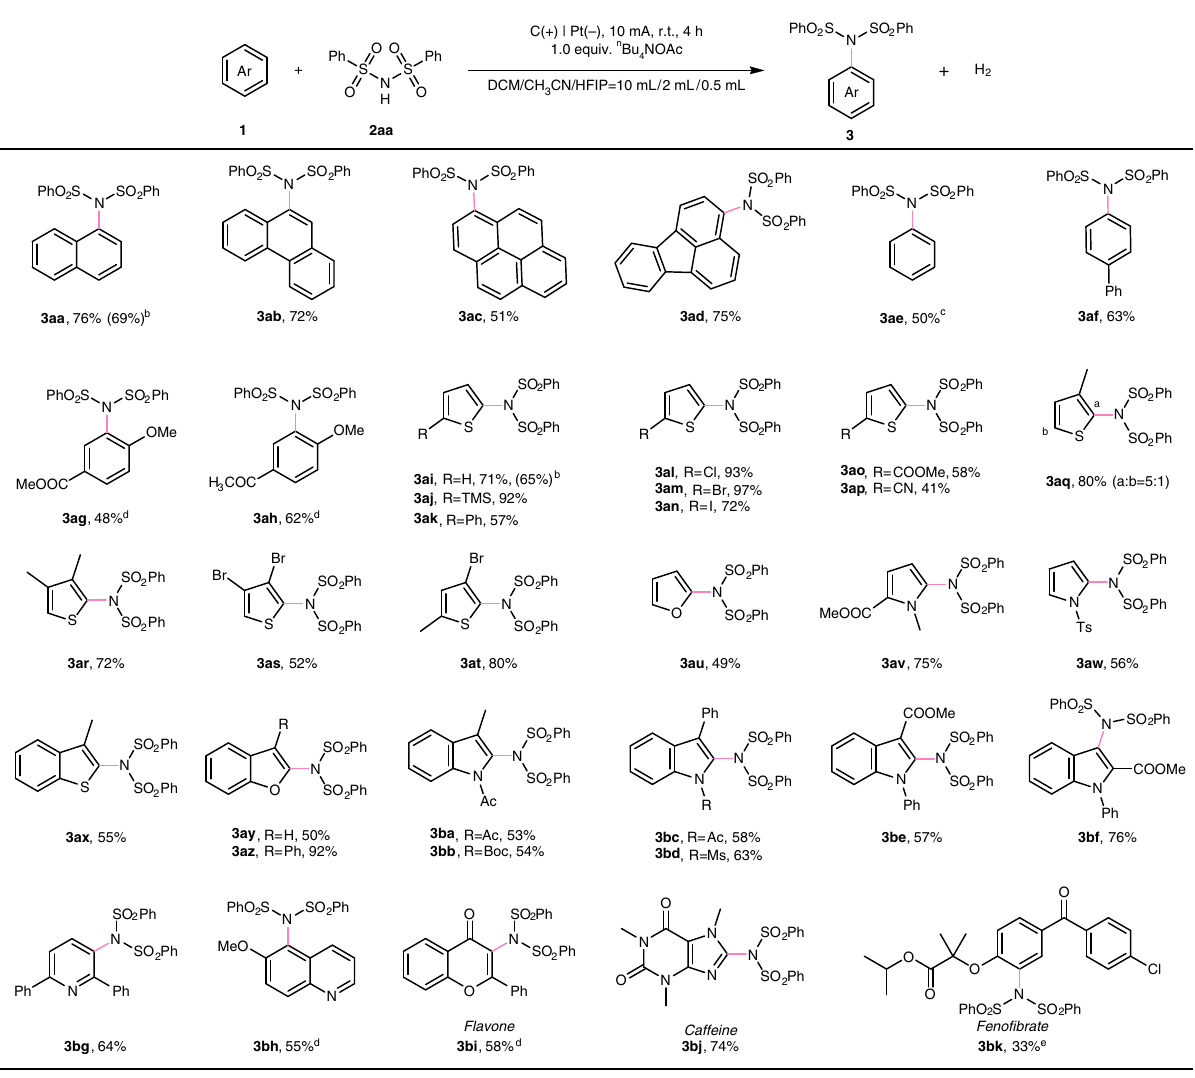
Fig. 2 Substrate scope of aromatic compounds. Reaction conditions: carbon rod anode, platinum plate cathode, constant current = 10 mA, 1 (0.40 mmol), 2aa (0.60 mmol), n Bu 4 NOAc (0.40 mmol), solvent (DCM/ CH 3 CN/ HFIP = 10 mL/2 mL/0.5 mL), undivided cell, N 2 , 4 h. Isolated yields. b 5 mmol scale.